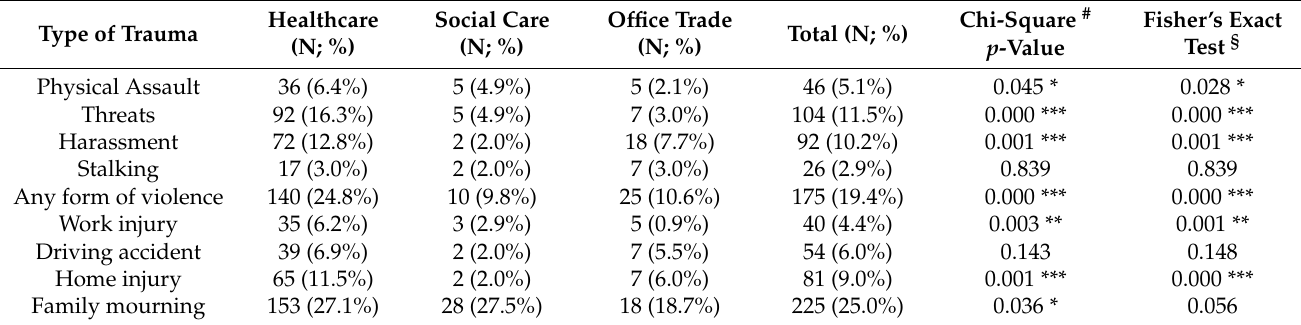
Table 1. One-year incidence of common traumas in some occupational sectors.